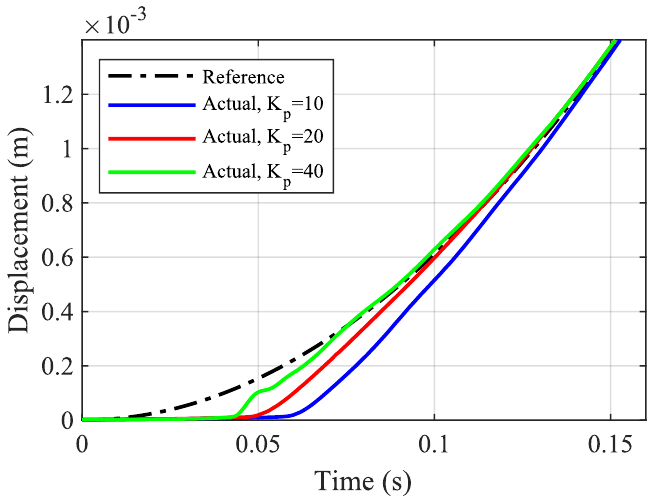
Figure 13. Zoomed view of the transient response for three sinusoidal position-tracking experiments at 0.25 Hz with K v = 20 and α = 5.